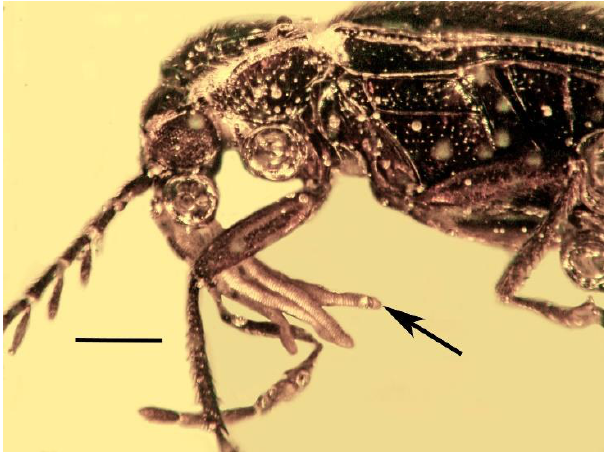
Figure 27. Ptilodactylid (Coleoptera: Ptilodactylidae) beetle with attached pollinarium (arrow) of Annulites mexicana (Angiospermae: Orchidaceae) in Mexican amber. Scale bar = 250 µm.